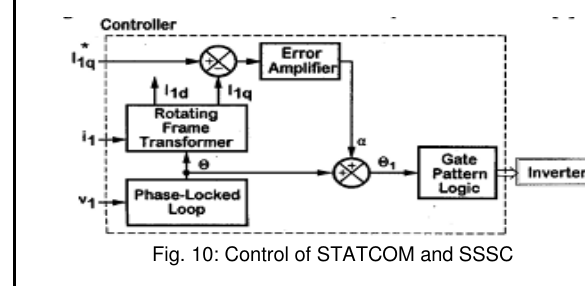
Fig. 10: Control of STATCOM and